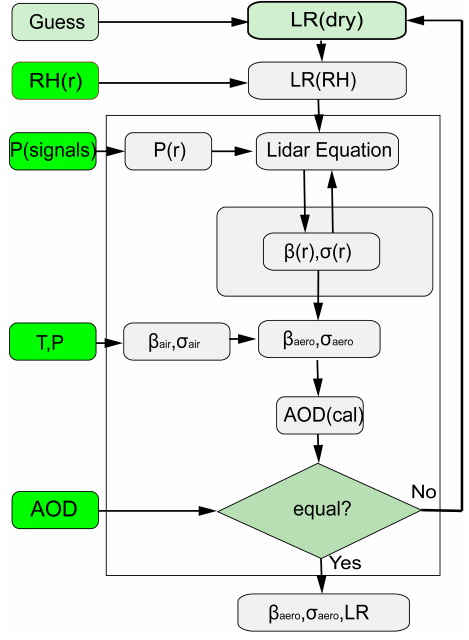
Figure 3. Schematic diagram of retrieving the σ ext profile. The in- put variables are displayed with a green